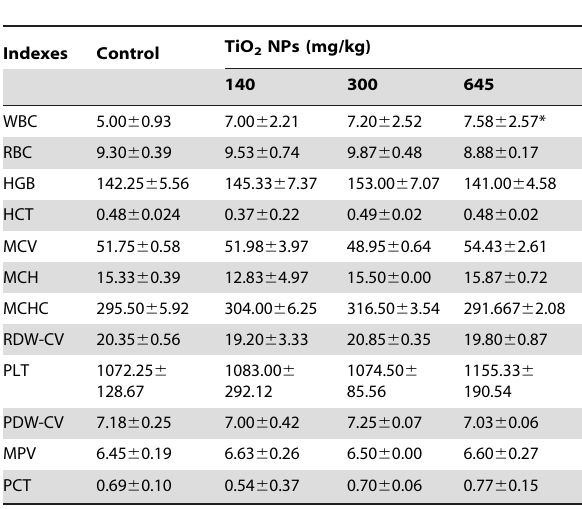
Table 4. Hematological parameters in the blood (Mean 6